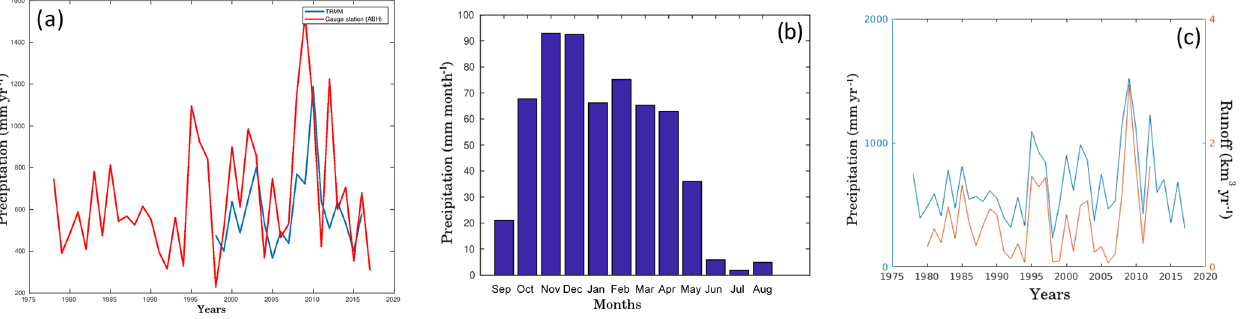
Figure 8. The hydrology of the Mjara watershed. (a) Interannual variability of precipitation and comparison with TRMM. (b) Monthly variability of precipitation. (c) Annual precipitation vs. annual